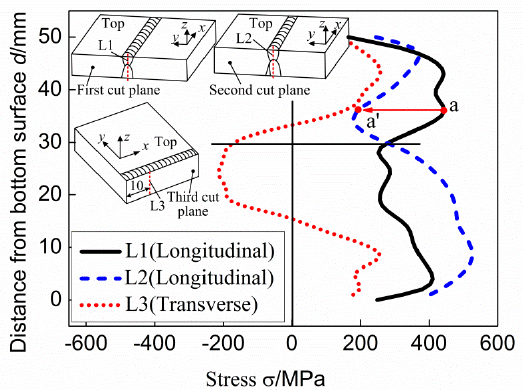
Figure 9. Stress variations along the thickness.